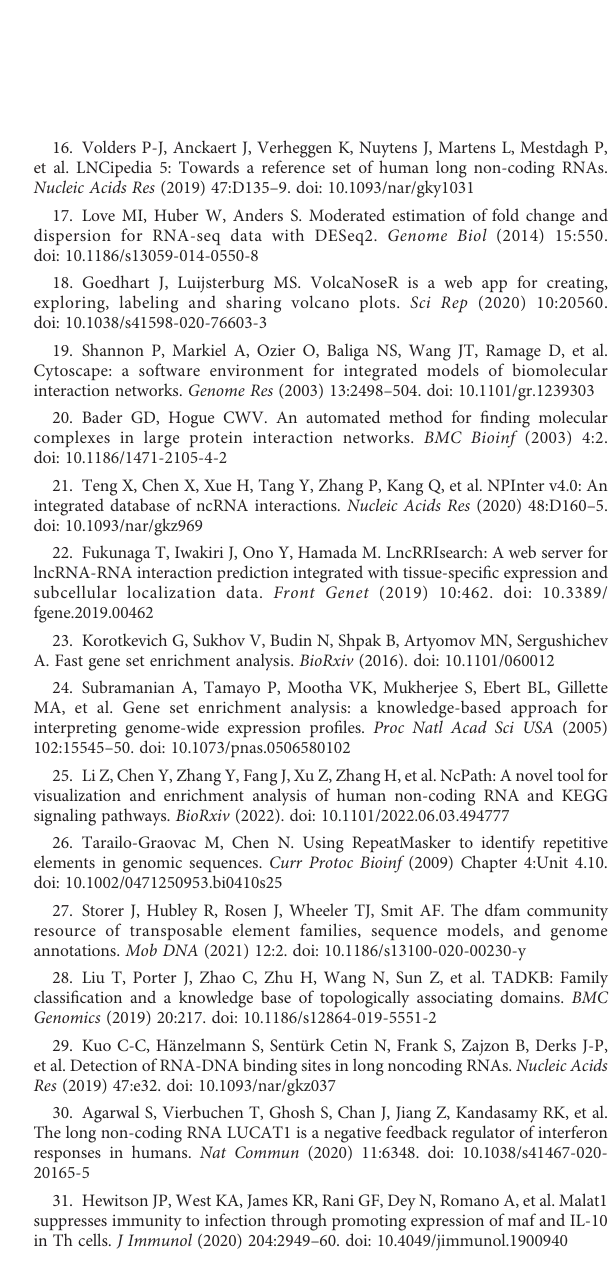
SUPPLEMENTARY TABLE S7 Repeat element distribution across interacting and non- interacting lncRNAs. SUPPLEMENTARY TABLE S8 LncRNAs and corresponding TAD genes. SUPPLEMENTARY TABLE S9 LncRNA-TAD gene interaction at promoter region. ASUPPLEMENTARY TABLE S10 Repeat element distribution between CDS and promoter region of TAD